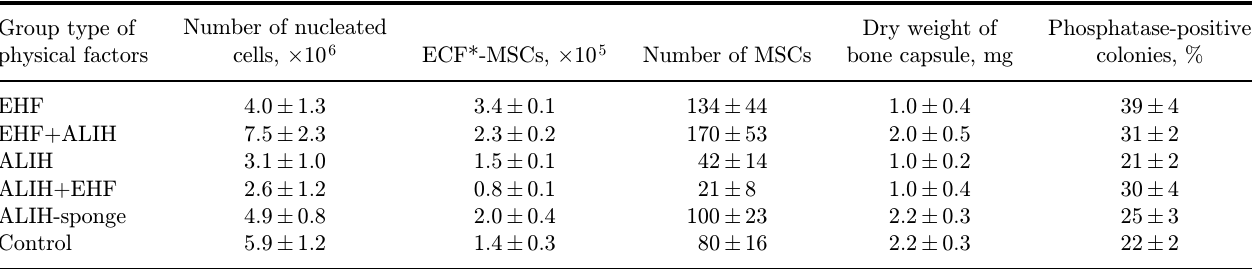
Table 2. Cell number, ECF-MSCs, weight of bone capsules, and phosphatase-positive colonies in ¯ve months transplants of bone marrow in mice ( M (cid:3) m